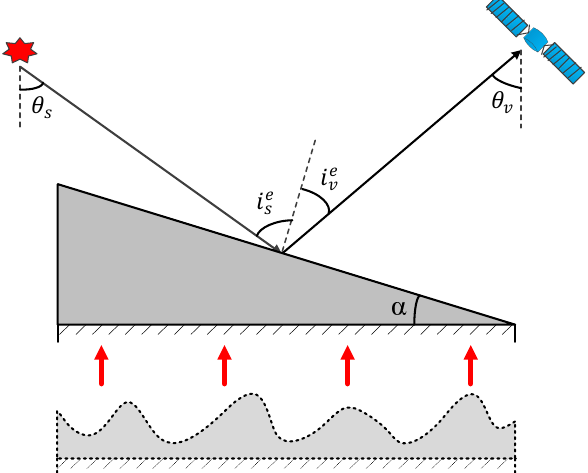
Figure 14. Equivalent slope: a virtual smooth surface.